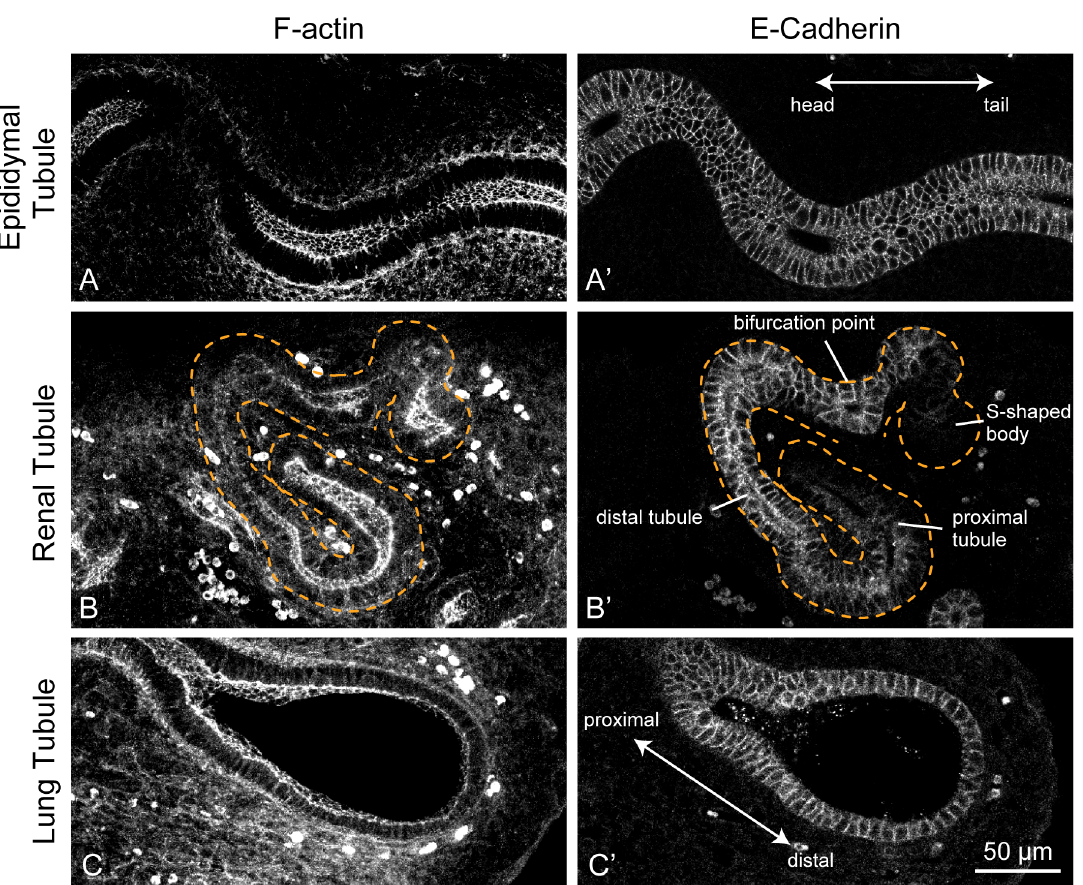
Fig 1. Whole-tissue fluorescence images of F-actin and E-cadherin. The spatial distribution of F-actin (left) and E-cadherin (right) during epididymal (upper), kidney (middle), and lung (bottom) development is shown. Each organ was dissected at E16.5 for epididymis and at E13.5 for both kidney and lung. Dotted orange lines in the middle row represent the tissue boundary of the epithelial renal tubule. For the images obtained with F-actin staining, a maximum intensity projection was applied over 30 μ m with 2- μ m intervals for the three organs. The E-cadherin images are single section views. Scale bar: 50 μ m.